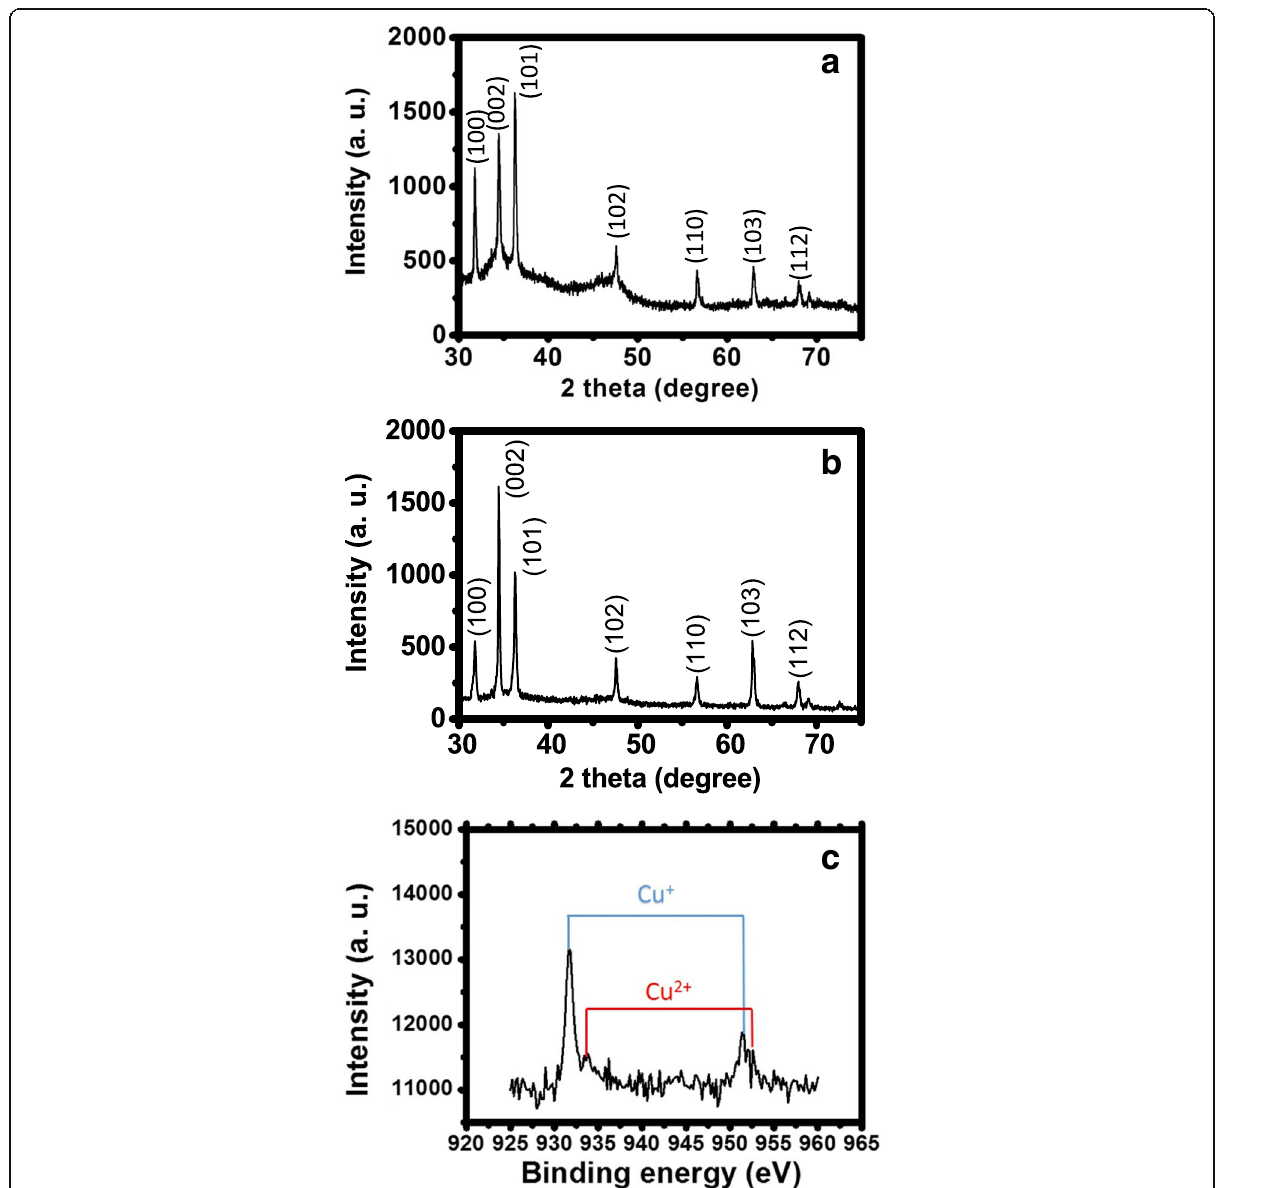
Fig. 5 a , b X-ray diffraction patterns of as-grown ZnO and Cu 2 O/ZnO NRs. c An XPS spectrum of Cu 2 O/ZnO